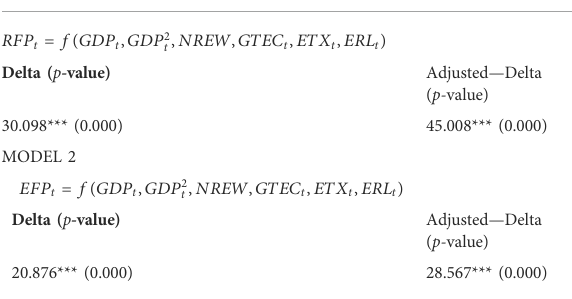
TABLE 3 The heterogeneity and homogeneity testing of slope co- ef fi cient. Model